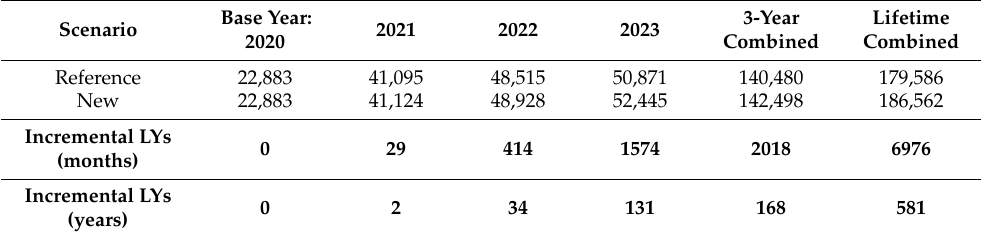
Table 9. Incremental population LYs